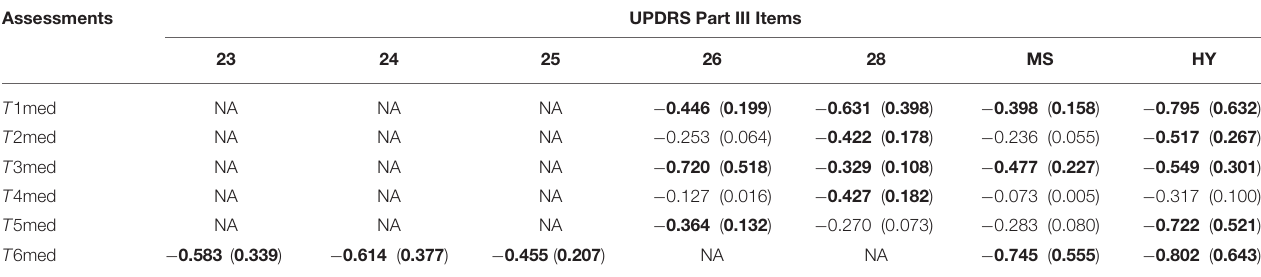
TABLE 3 | Estimated correlation r and coefficient of determination ( r 2 ) between the median values of the Final Motor Score for ( T 1 − T 6) and the UPDRS Part III Items. Assessments